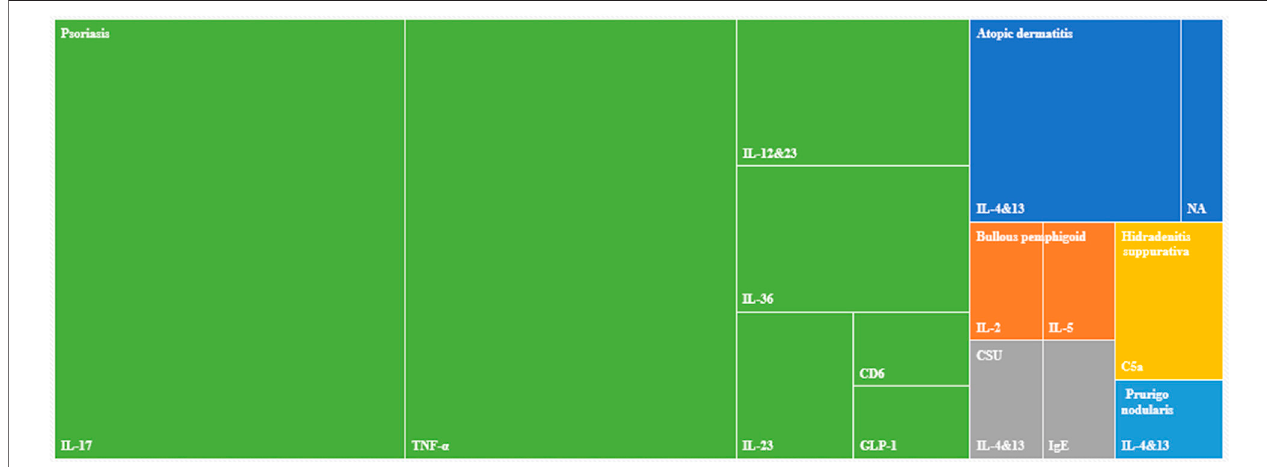
FIGURE 3 | Distribution of biologic target and